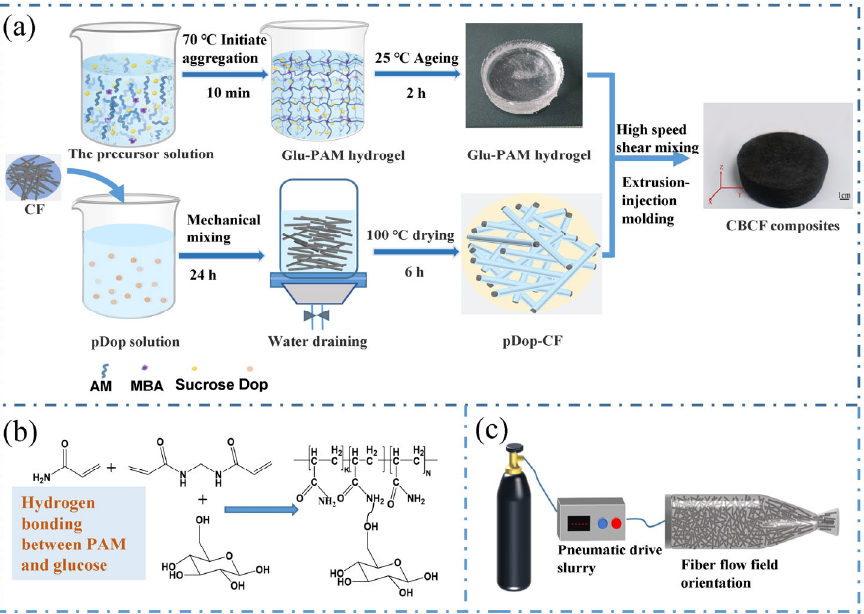
Figure 1. ( a ) Flow chart of CBCF slurry preparation; ( b ) reactions in the gelation process; ( c ) sche ‐ matic diagram of the homemade extrusion molding